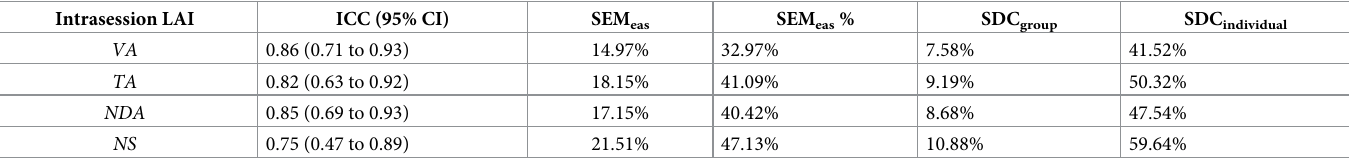
Table 4. Intrasession reliability statistics LAI. SEM eas , SDC individual, SDC group are expressed as a percentage of the unconditioned MEP. In contrast, %SEM eas is expresses the SEM eas as a percentage of the